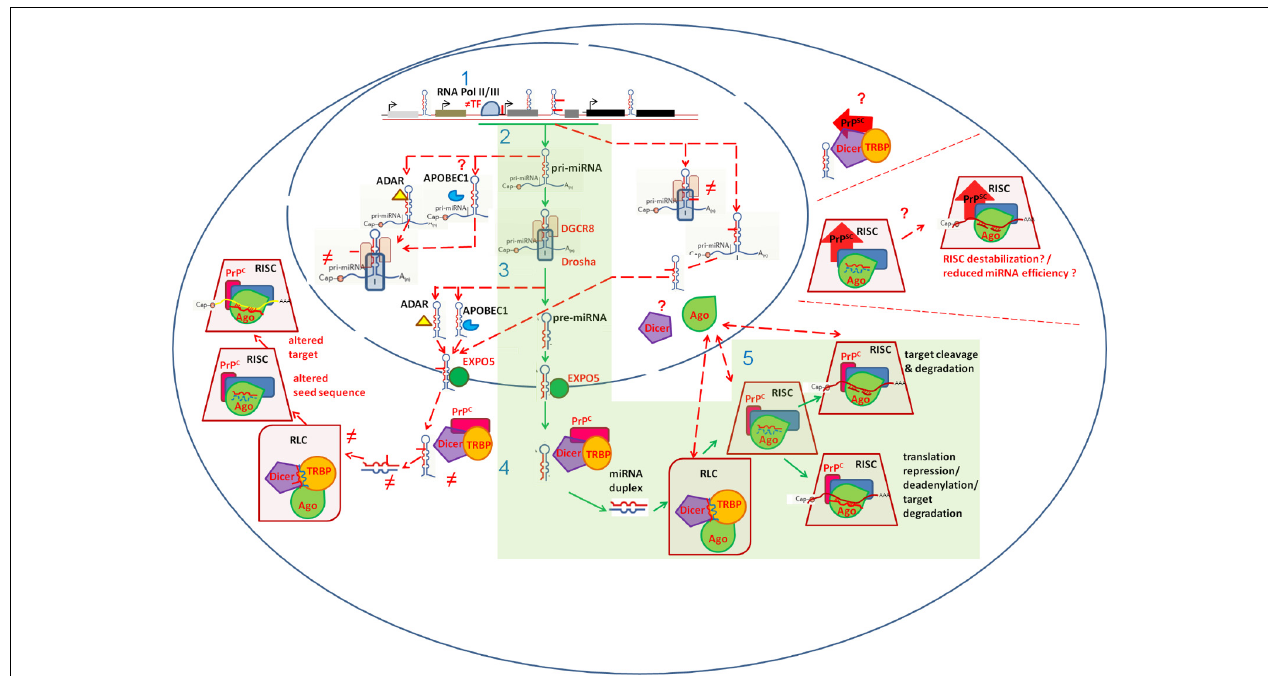
FIGURE 2 | Schematic representation of cellular mechanisms possibly implicated in miRNA dysregulation in prion diseases. The canonical miRNA biogenesis and function pathway is indicated in green boxes. Mechanisms possibly contributing to miRNA dyregulation in prion diseases are indicated with dashed red lines. miRNA genes, residing in exonic, intronic or intergenic regions, are transcribed by RNA polymerase II or III (1) . Altered miRNA gene transcription rate may impact miRNA levels. This can be associated to altered ( (cid:54)= ) abundance of Transciption Factors (TF) inducing miRNA gene expression (e.g., STAT3), and/or to Single Nucleotide Variants (SNPs) residing within miRNA-gene promoter regions (e.g., rs57095329, illustrated as solid red line). Upon transcription, pri-miRNAs’ flanking sequences are removed by the microprossesor complex, containing Drosha and DGCR8 (2) . This processing generates pre-miRNA stem-loop structures (3) . Pre-miRNAs are exported into the cytoplasm through Exportin5 (EXPO5). Dicer removes the pre-miRNA loop, generating a miRNA duplex (4) . SNPs in miRNA genes may interfere with pri- and/or pre-miRNAs processing by Drosha/DGCR8 (2) and Dicer (4) respectively. RNA editing, mediated by ADARs and/or APOBEC1, may occur in pri- and/or pre-miRNAs, introducing Single Nucleotide Variants (SNVs) with the potential to affect miRNA maturation (2, 4) . Reduced Drosha, DGCR8 and Dicer levels, reported in human prion diseases, may impact miRNA maturation (2, 4) . Following Dicer processing, the miRNA duplex is loaded from the RISC-loading complex (RLC) onto RISC. Ago proteins, are core components of RISC, forming the active functional unit of the miRNA-mediated gene regulation (5) . Abnormal subcellular localization of Ago proteins, reported in sCJD, may affect miRNA machinery (5) . PrP C -Ago interactions, which stabilize RISC, may be affected by PrP Sc presence. Similarly, PrP Sc could possibly impact PrP C -Dicer interactions and thus miRNA maturation and function. Incorporated into the RISC complex, miRNAs promote either translational repression or mRNA degradation, according to sequence complementary (5) . SNPs in miRNA seed sequences and/or RNA editing events possibly occurring within miRNA seed sequences may impact miRNA-target mRNA interactions and even redirect miRNAs in new targets (5)